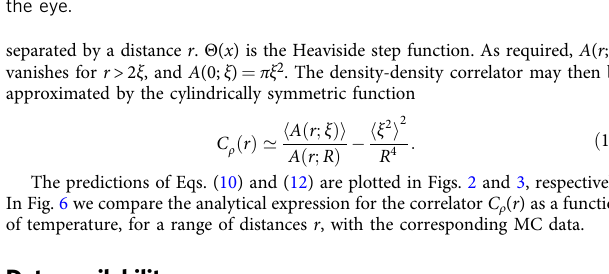
Fig. 6 Temperature dependence of real-space vison correlations. We show the vison density correlator C ρ ( r ) as a function of temperature at distances r = 1, 3, … , 9 for a system of size L 2 = 20 2 . a Theoretical predication from Eq. (12) using the disc free energy in Eq. (3). b The corresponding MC data. The solid lines through the MC data are a guide to the